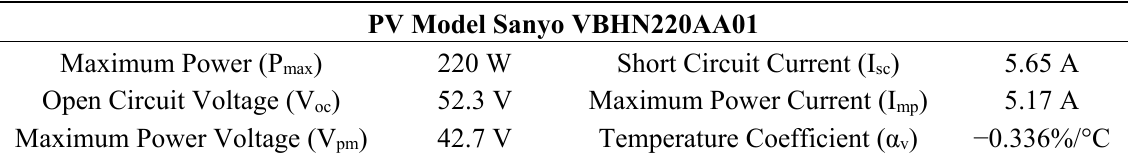
Table 2. Parameters of the utilized PV panel.